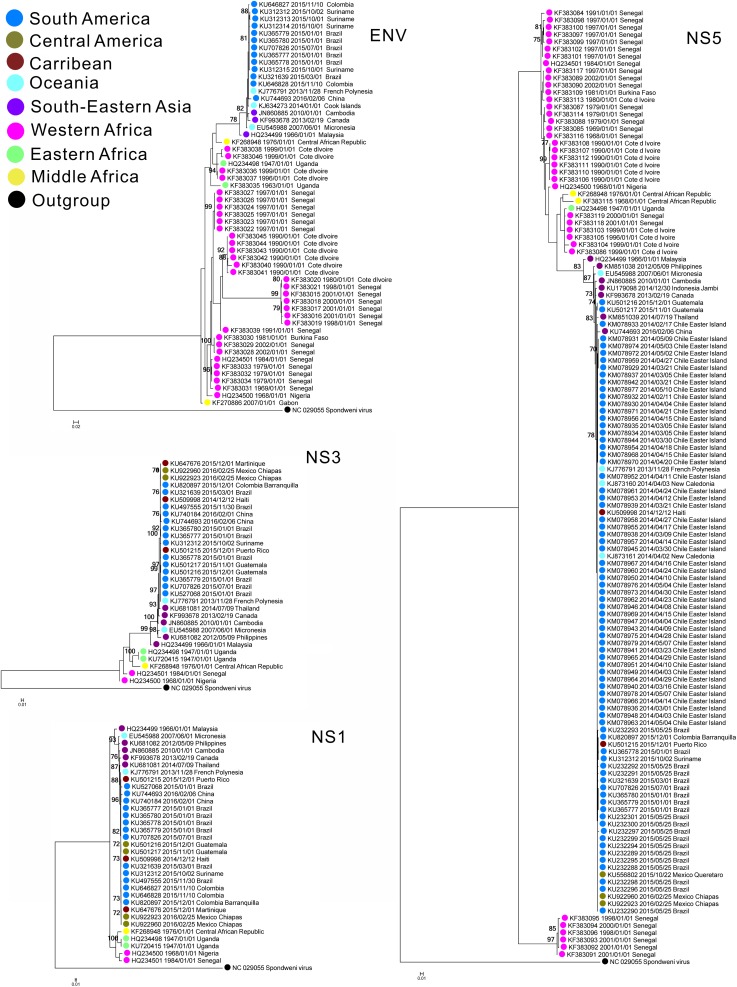
Maximum likelihood based phylogenetic tree with envelope protein E (ENV), nonstructural protein 1 (NS1), nonstructural protein 3 (NS3) and nonstructural protein 5 (NS5) sequences of the Zika virus (ZIKV).These trees are summarized after 1 000 replicates. Bootstrap values smaller than 70 are not shown. Since the evolutionary relationships of flaviviruses have been characterized[41], we used one of the closest evolutionary relationships species in flaviviruses, namely Spondweni virus (SPOV), to root the trees. The location for imported cases was assigned to the source country.